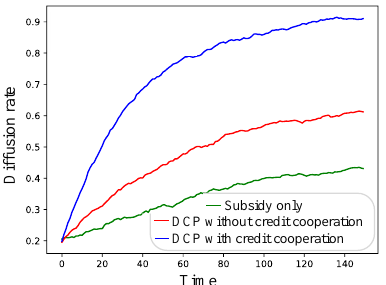
Figure 7. Results in small world network.